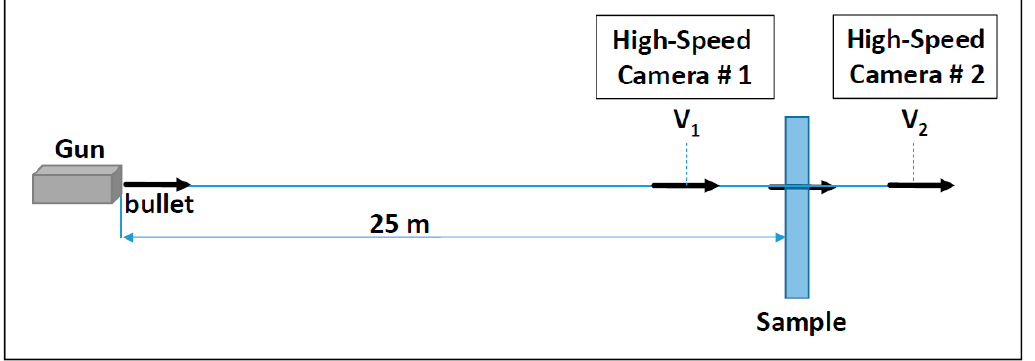
Figure 4. Schematic of the ballistic test setup.